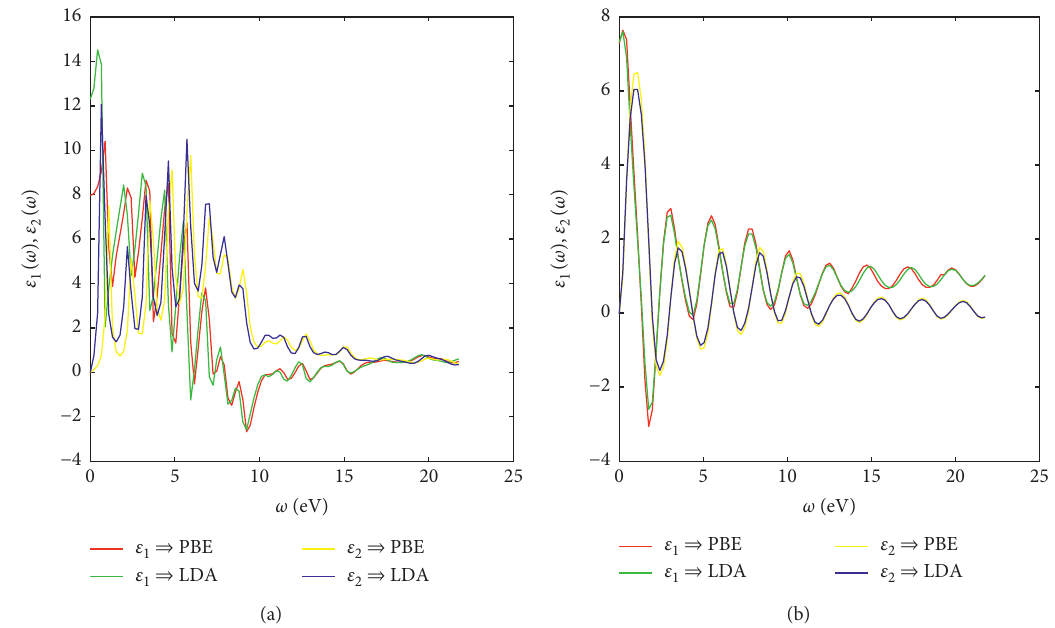
Figure 4: Real and imaginary parts of dielectric function for (a) zb-CdS and (b) wz-CdS.